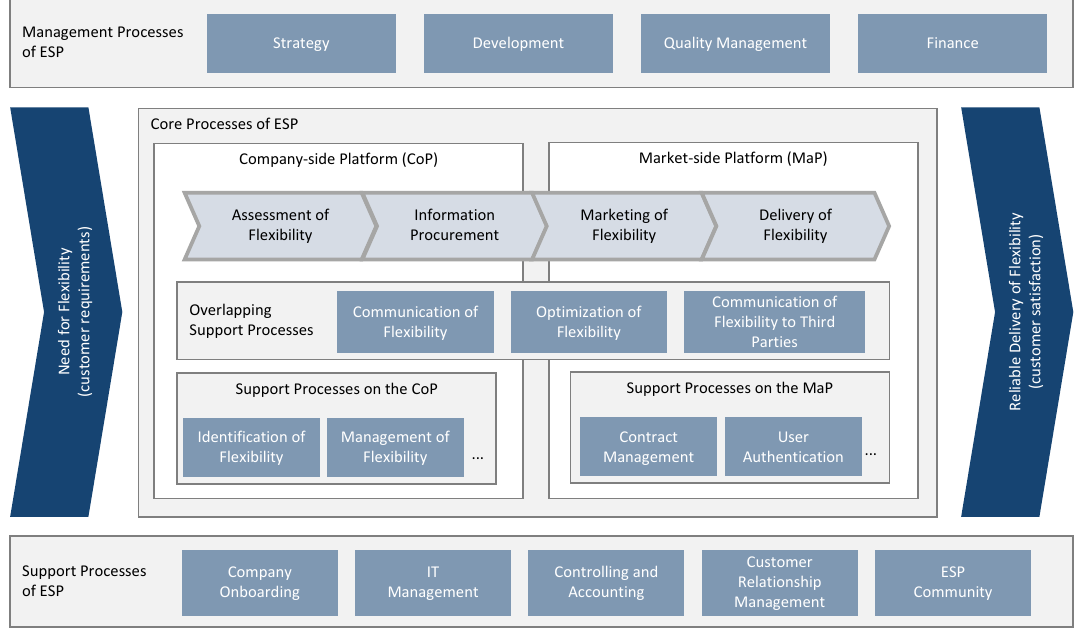
Figure 6. Process map of the energy synchronization